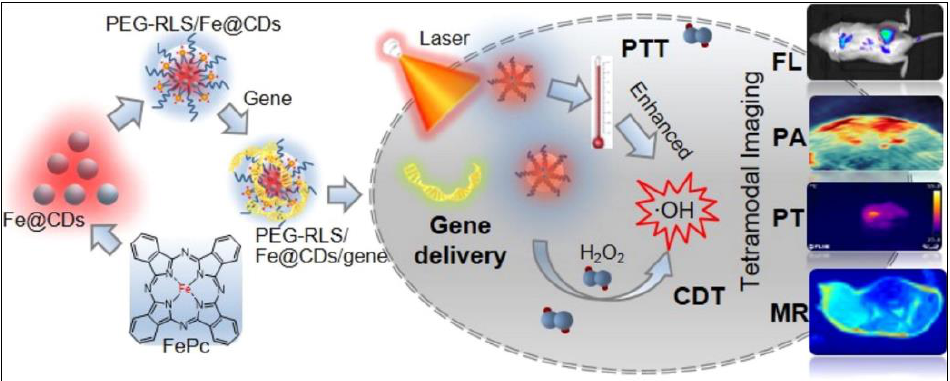
Figure 9. Schematic representation of the formation of the multimodal theranostic nanoparticles based on iron-doped carbon dots (Fe@CDs) as the photoactivated nanozyme. The gene-loaded nanoparticles were capable of tetramodal imaging (FL: fluorescence; PA: photoacoustic; PT: photothermal; and MR: magnetic resonance), along with laser-light-activated photothermal therapy (PTT) and a Fenton-reaction-driven chemodynamic therapy (CDT), for a potent antitumor effect. Reprinted with permission from Ref. [97]. Copyright 2021 Elsevier.